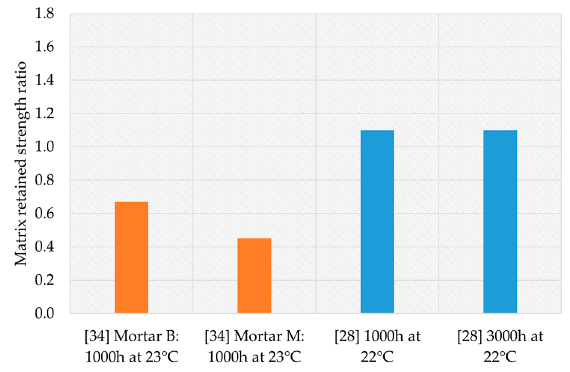
Figure 4. Effect of the alkaline environment on the matrices (blue bin = cement-based matrix and orange bin = lime-based matrix).